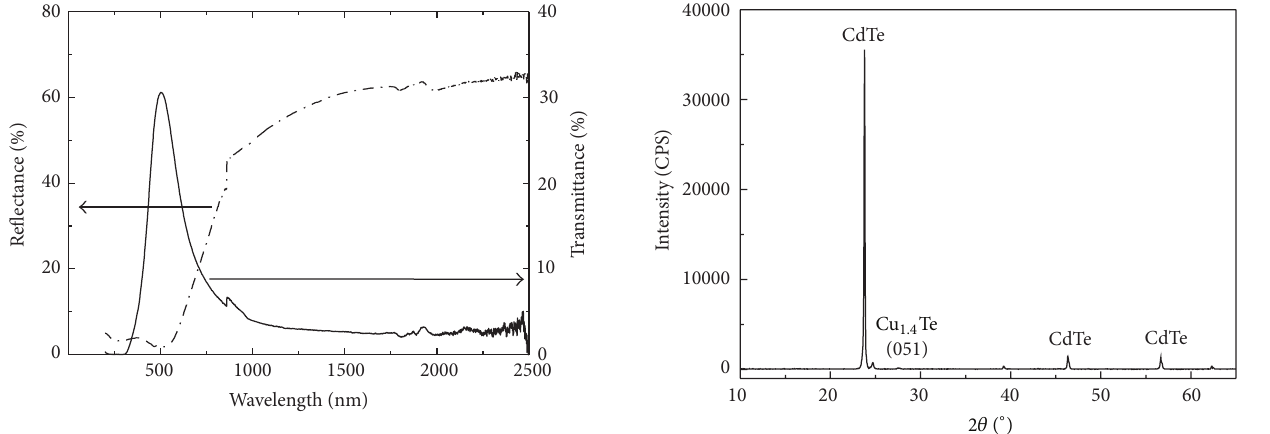
Figure 4: XRD pattern of Cu 1.4 Te thin films deposited on the CdTe thin